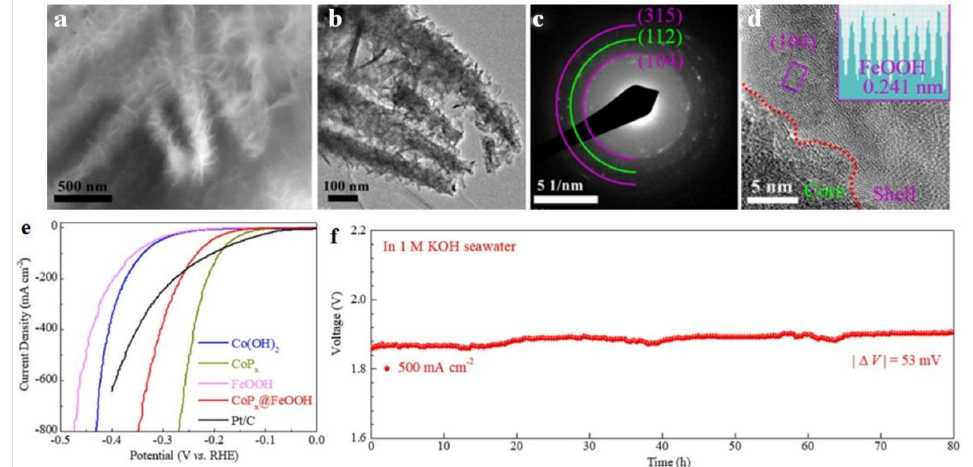
Figure 8. ( a – d ) SEM, TEM, HRTEM images and SAED pattern of CoP x @FeOOH; ( e ) HER polarization curves of various electrocatalysts; ( f ) chrono-potentiometric measurement of CoP x ||CoP x @FeOOH in 1.0 M KOH water electrolyte, reused from